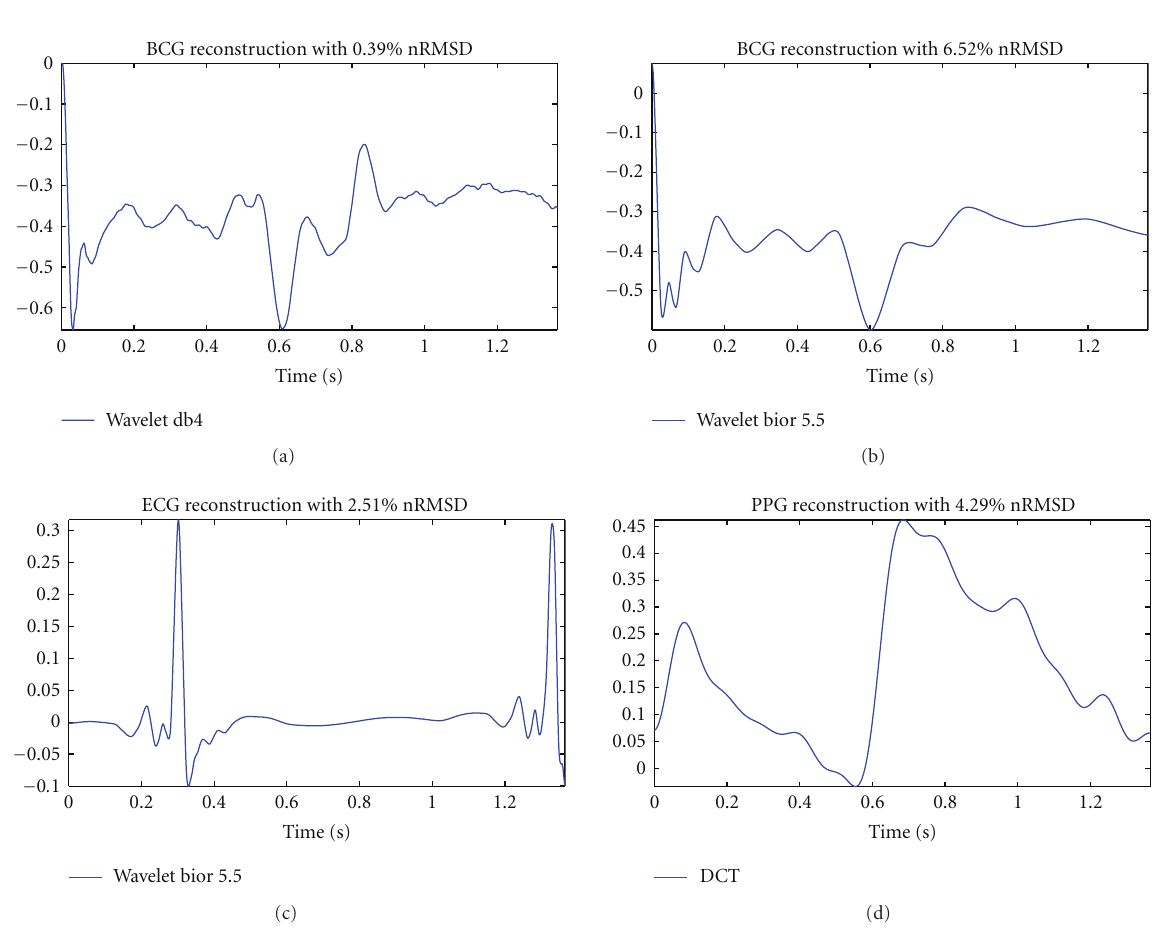
Figure 8: Example of reconstructed signals and the respective nRMSD.